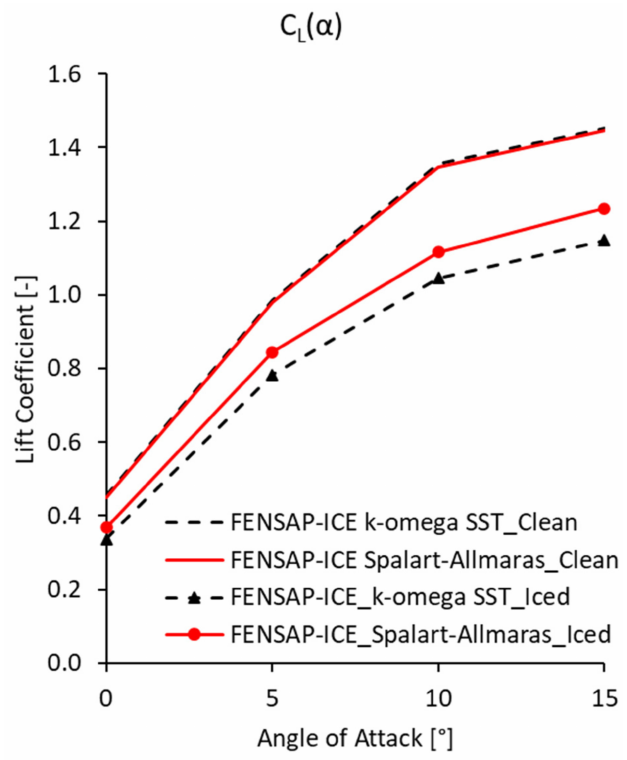
Figure 14. Lift coefficient (clean vs. iced).